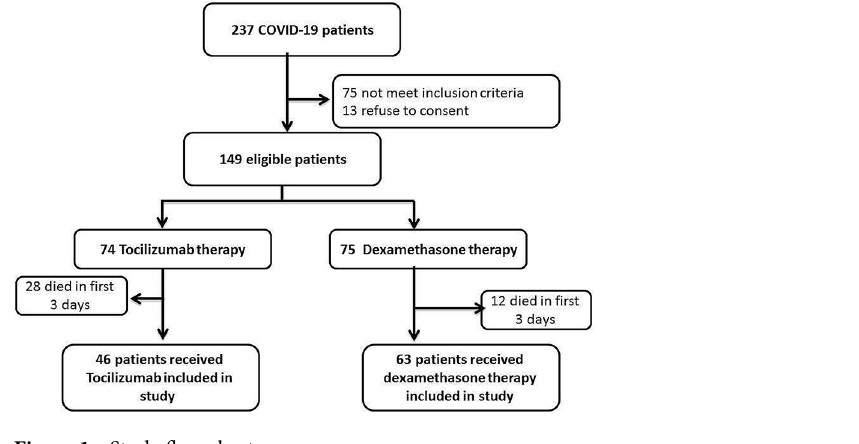
Figure 1. Study flow